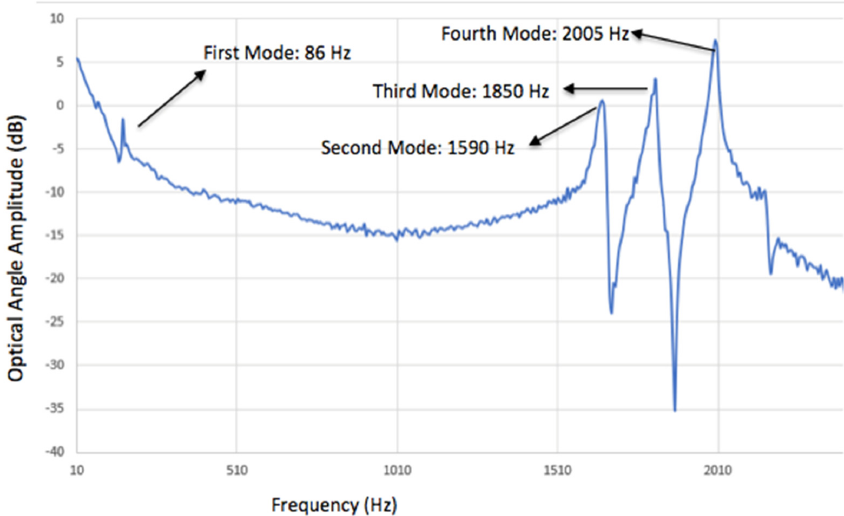
Figure 12. Frequency response of the MEMS device.